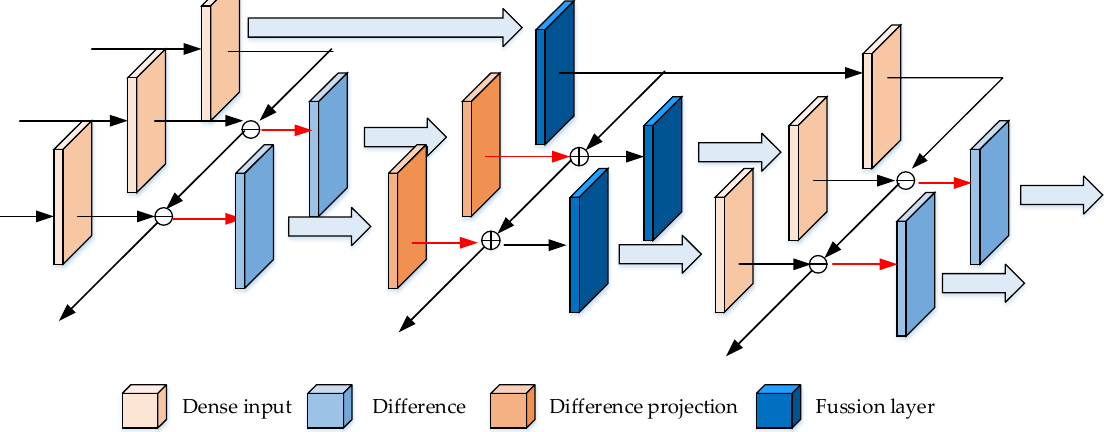
Figure 24. The structure of RRM. ⊖ represents the feature map subtraction operation, which can highlight the differences among the adjacent frames. ⊕ represents the plus operation, which can highlight the similarities among the adjacent frames.